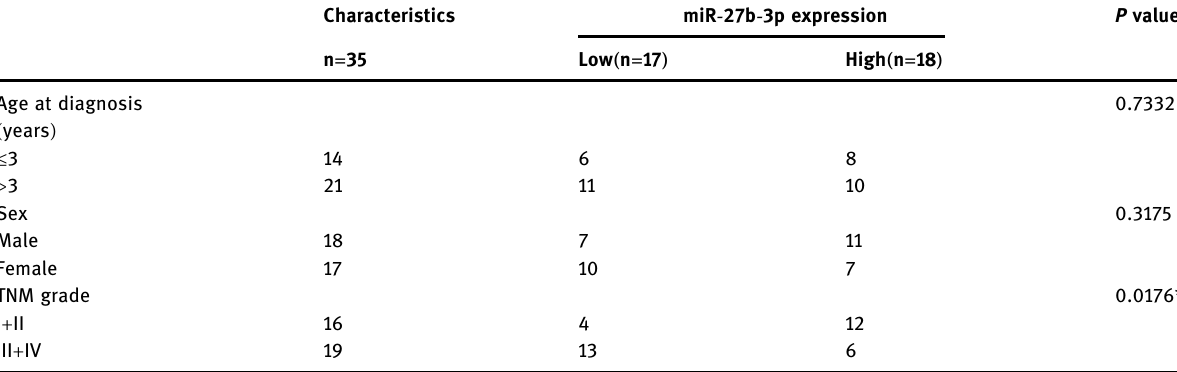
Table A1: Relationship between miR - 27b - 3p expression and clinicopathologic features of neuroblastoma patients